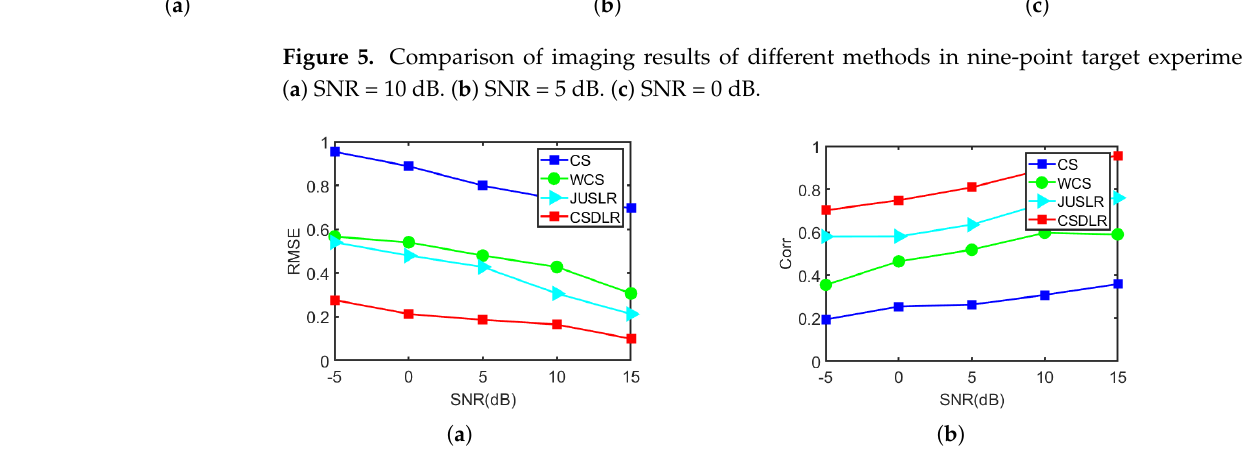
Figure 6. Performance comparison of different imaging methods in point target experiment. ( a )